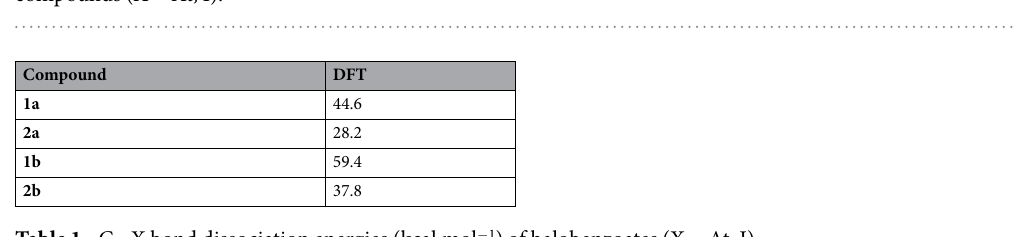
Figure 3. Scheme to assess the effect of oxidation on the C − X bond dissociation energies of halobenzoate compounds (X = At,